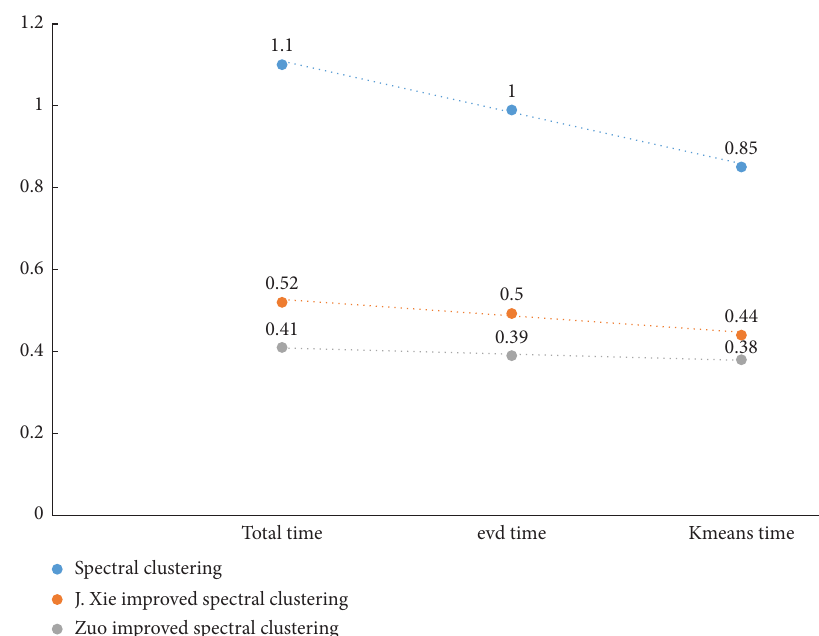
Figure 9: Te average computing time of 10 experimental clusters of the three